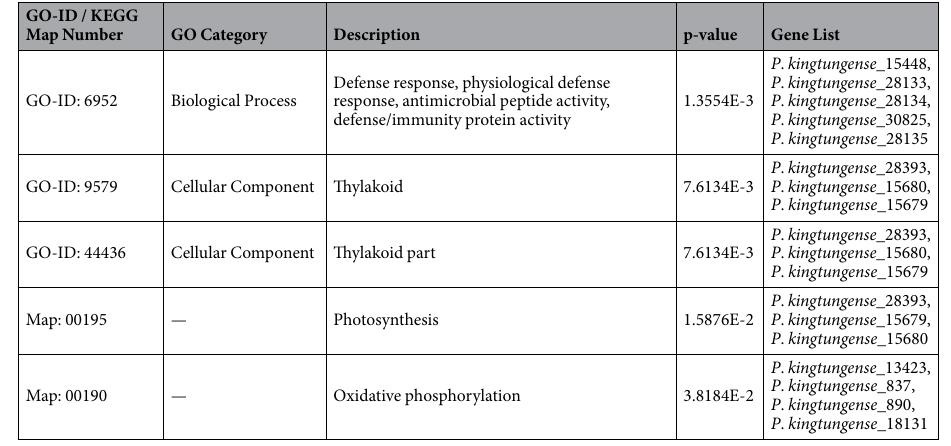
Table 2. Functional character of P. kingtungense specific genes.